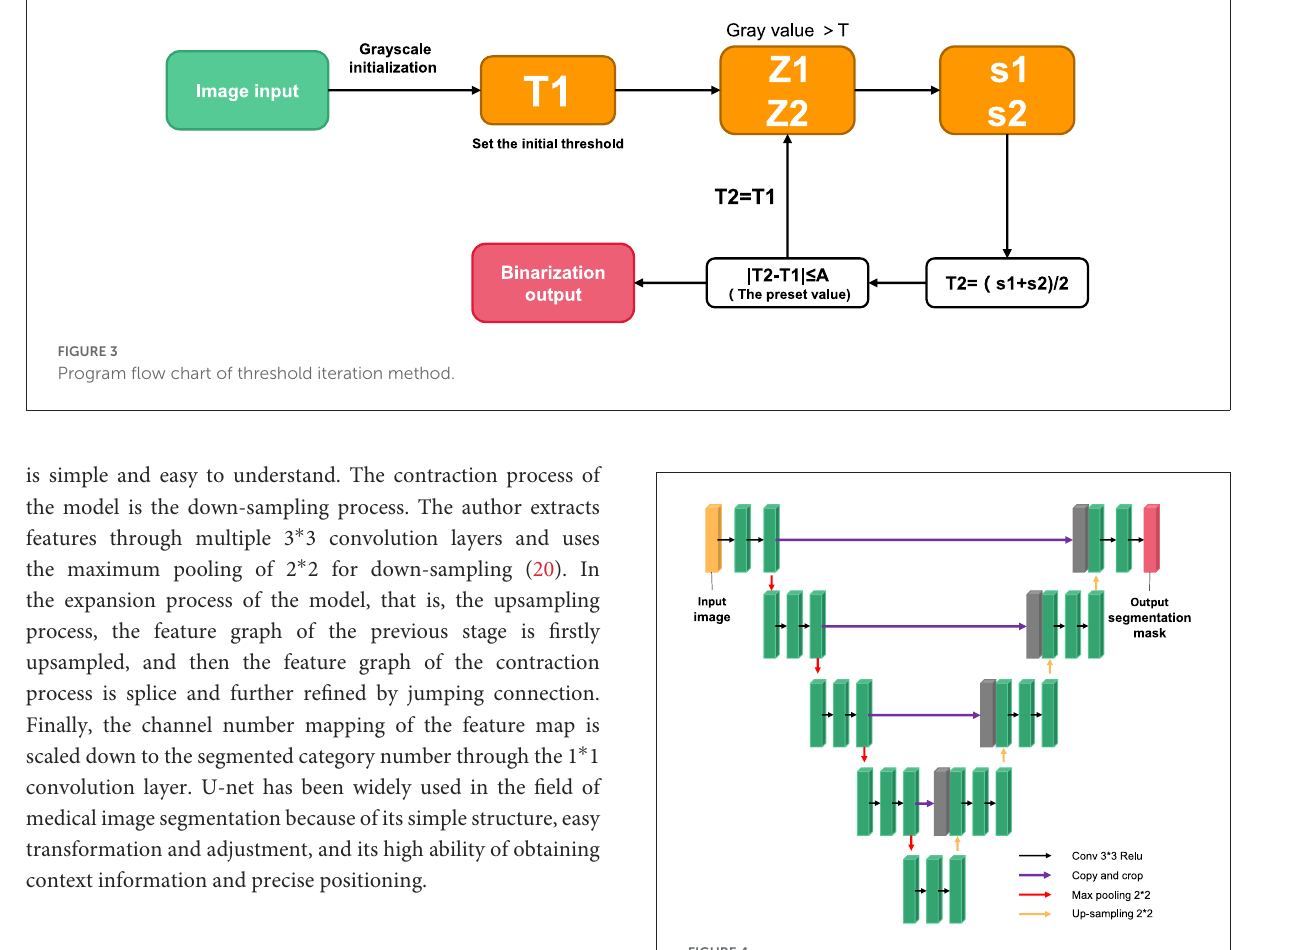
FIGURE4 U-NET network